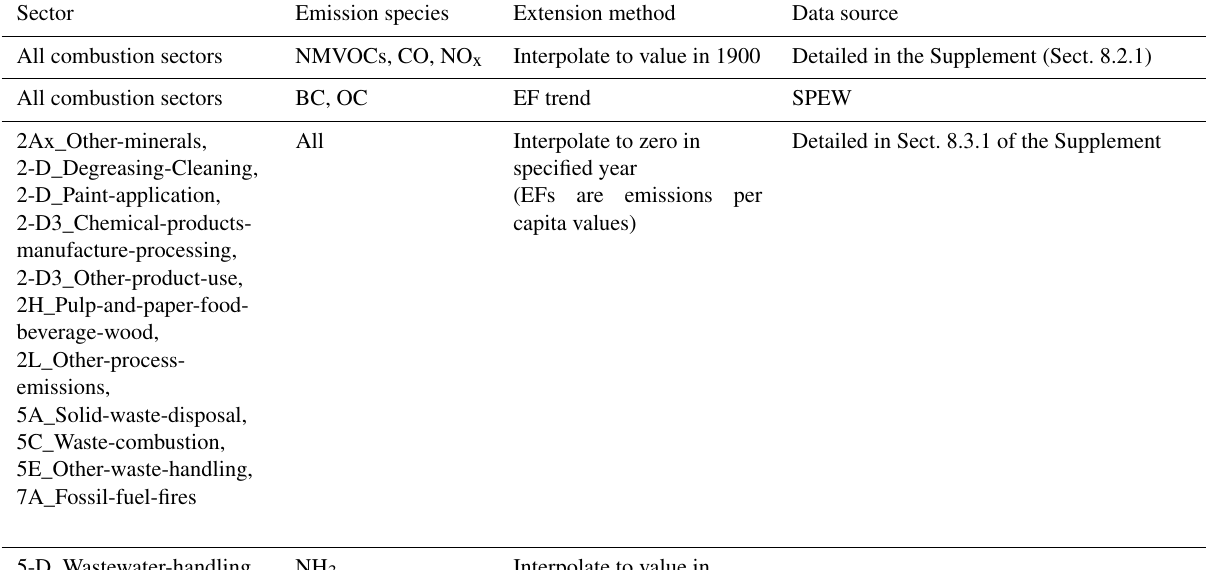
Table 5. Historical extension method and data sources for emission